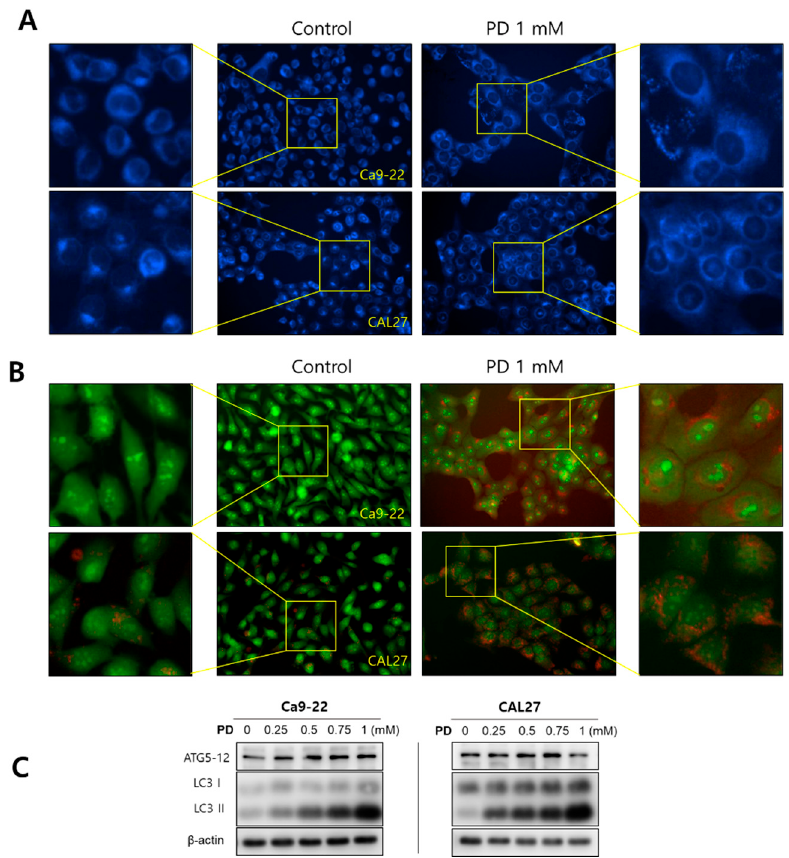
Figure 4. Induction of autophagy by polydatin in OSCC cells. ( A ) MDC staining and ( B ) AO staining were performed to detect autophagosomes and AVOs. ( C ) Ca9-22 and CAL27 cells were treated with 0–1 mM polydatin, and the expression of the autophagy-related proteins Atg5 and LC3B was confirmed. β -actin was used as loading control.